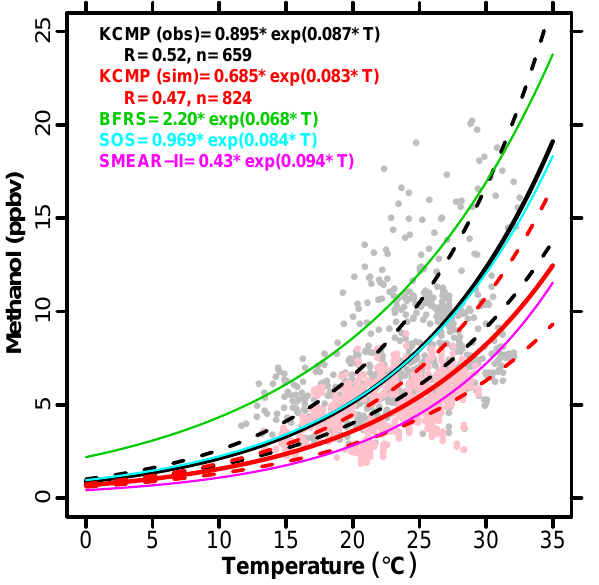
Fig. 7. Methanol concentrations (ppbv) versus temperature ( ◦ C). Shown are observed (black) and simulated (red) methanol concen- trations at the KCMP tall tower during daytime in summer (June- August; 07:00–18:00 LST). Solid lines (black and red) show an ex- ponential fit (major axis regression) to the observations and model output, with regression parameters given inset and 95% confidence intervals shown by the dashed lines. Also shown are the correspond- ing exponential fits derived from previous studies in California US (BFRS, Schade and Goldstein, 2006); Tennessee US (SOS, Riemer et al., 1998); and Hyyti¨al¨a Finland (SMEAR-II, Lappalainen et al., 2009).